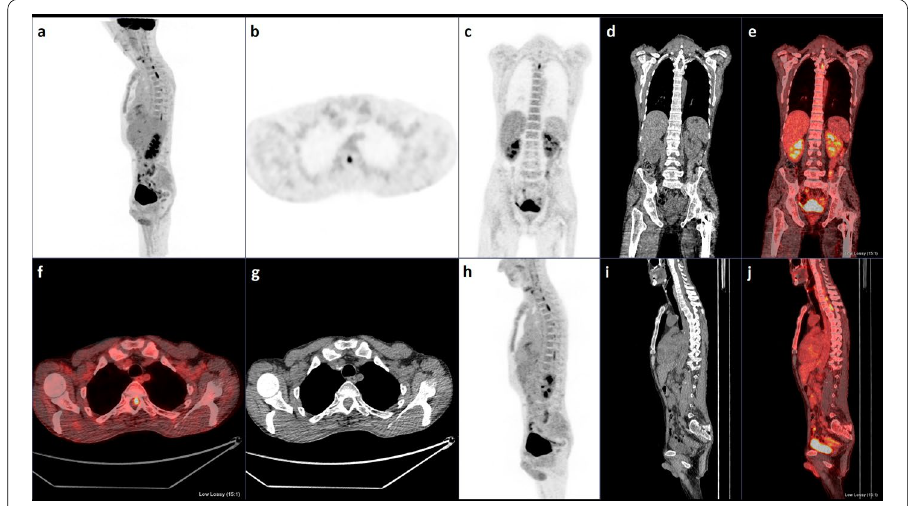
Fig. 1 Sagittal MIP image ( a ) from whole-body 18 F-FDG-PET/CT demonstrates intense multifocal segmental uptake in the cervical and thoracic spine (SUVmax 9.6). Axial ( b, f, g ), coronal ( c, d, e ) and sagittal ( h, i, j ) images confirm the intramedullary location of the